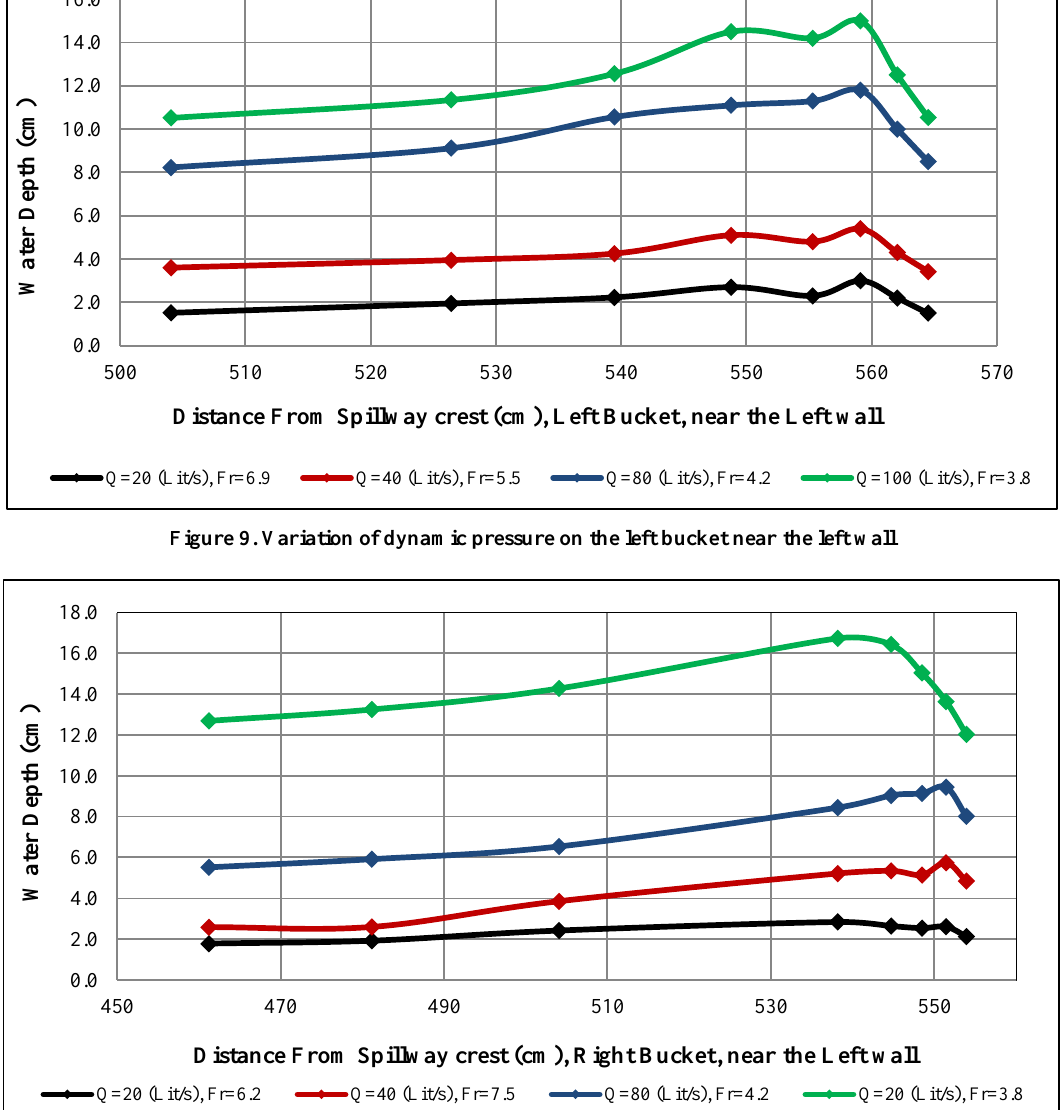
Figure 10. Variation of dynamic pressure on the right bucket near the left